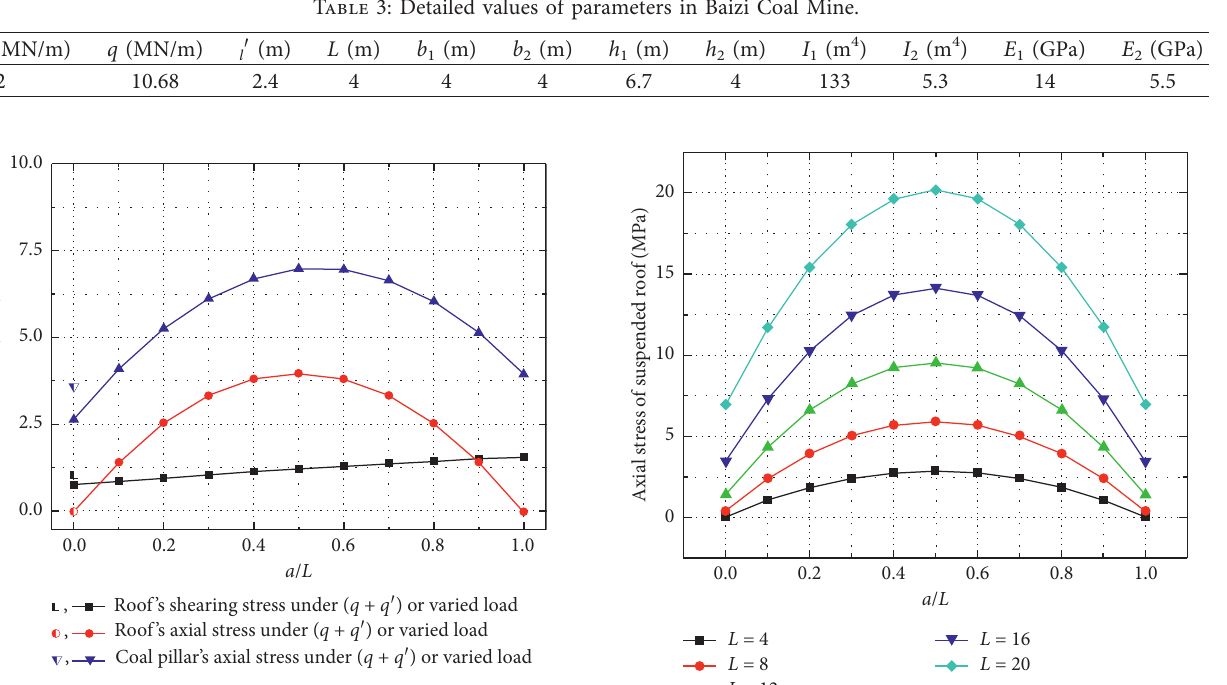
Figure 7: The relationship between stresses and “ a / L ” in Baizi Coal